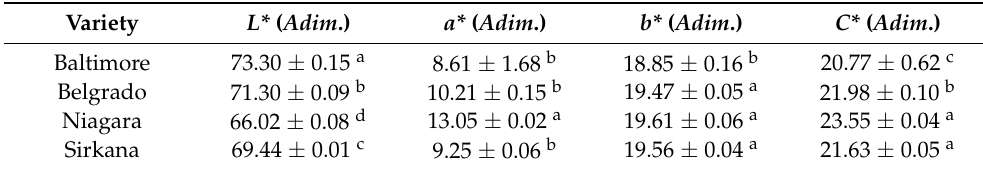
Table 3. Color CIE Lab parameters of carrot pomace